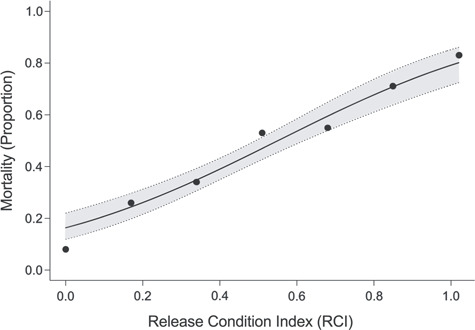
The relationship between observed release condition index (0 = no impairment; 1 = total impairment) and the proportional delayed mortality (0 = 0% mortality; 1 = 100% mortality) for black sea bass discard. Data points are plotted along a prediction function based on the g4 model response variable. The 95% confidence intervals are shown as the shaded area